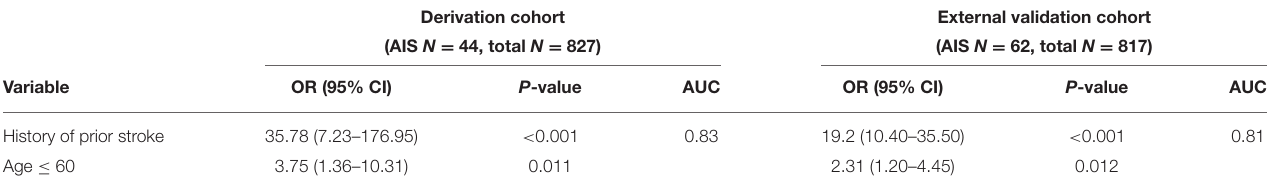
TABLE 4 | Predictors of acute ischemic stroke vs. no ischemic stroke among patients with a neurologic symptom in the derivation and validation cohorts.